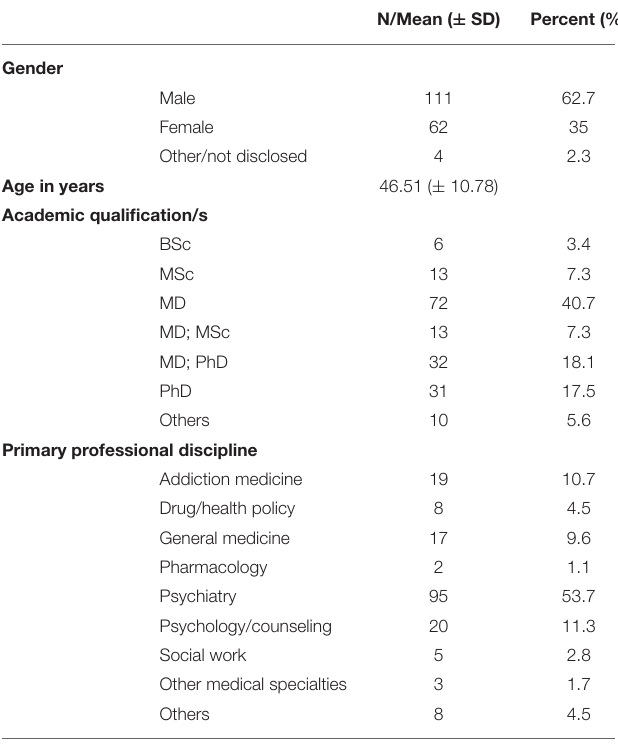
TABLE 1 | The demographic and professional information of survey respondents including their gender, age, academic degree, and primary